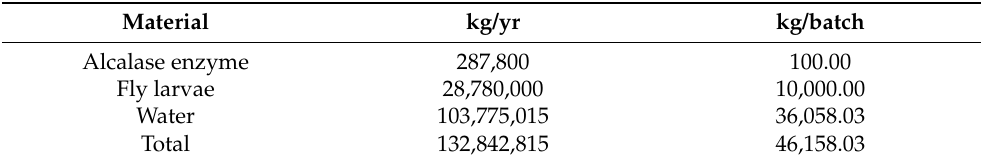
Table 8. Bulk material consumption for each